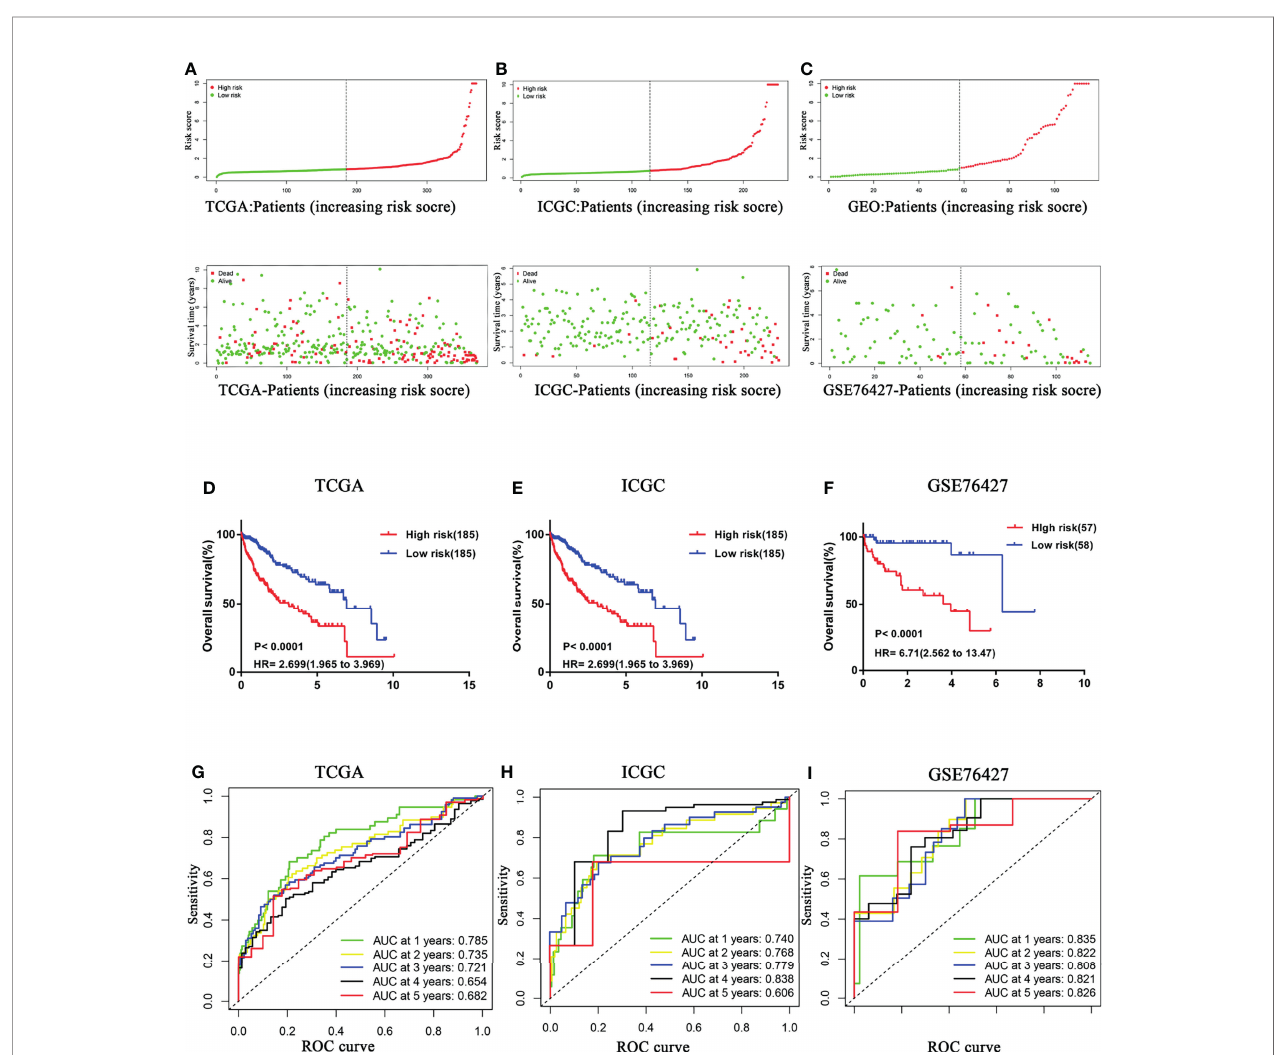
FIGURE 2 | Con fi rmation of the prognostic signature. HCC samples were dichotomized into two categories according to median risk score in (A) TCGA, (B) ICGC, and (C) GSE76427 cohorts. HCC patients with a low risk score possessed signi fi cantly longer OS in (D) TCGA, (E) ICGC, and (F) GSE76427 cohorts. Time- dependent ROC curves of the CCS for prediction of the 1-, 2-, 3-, 4-, and 5-year OS in (G) TCGA, (H) ICGC, and (I) GSE76427 cohorts. OS, overall survival; ROC, Receiver operating